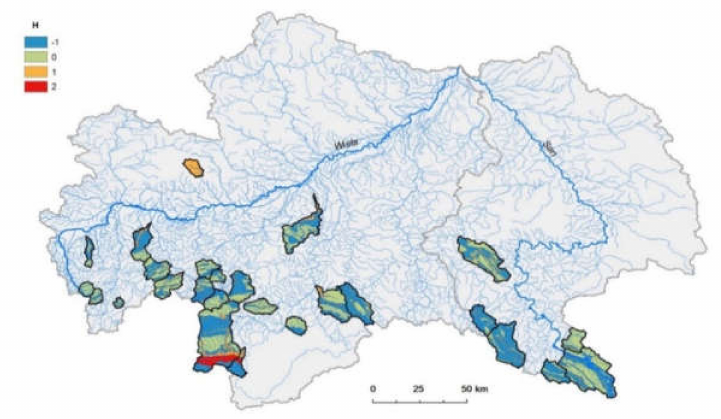
Figure 3. Hydrogeological characteristics ( H ) of analyzed catchments in the Upper Vistula